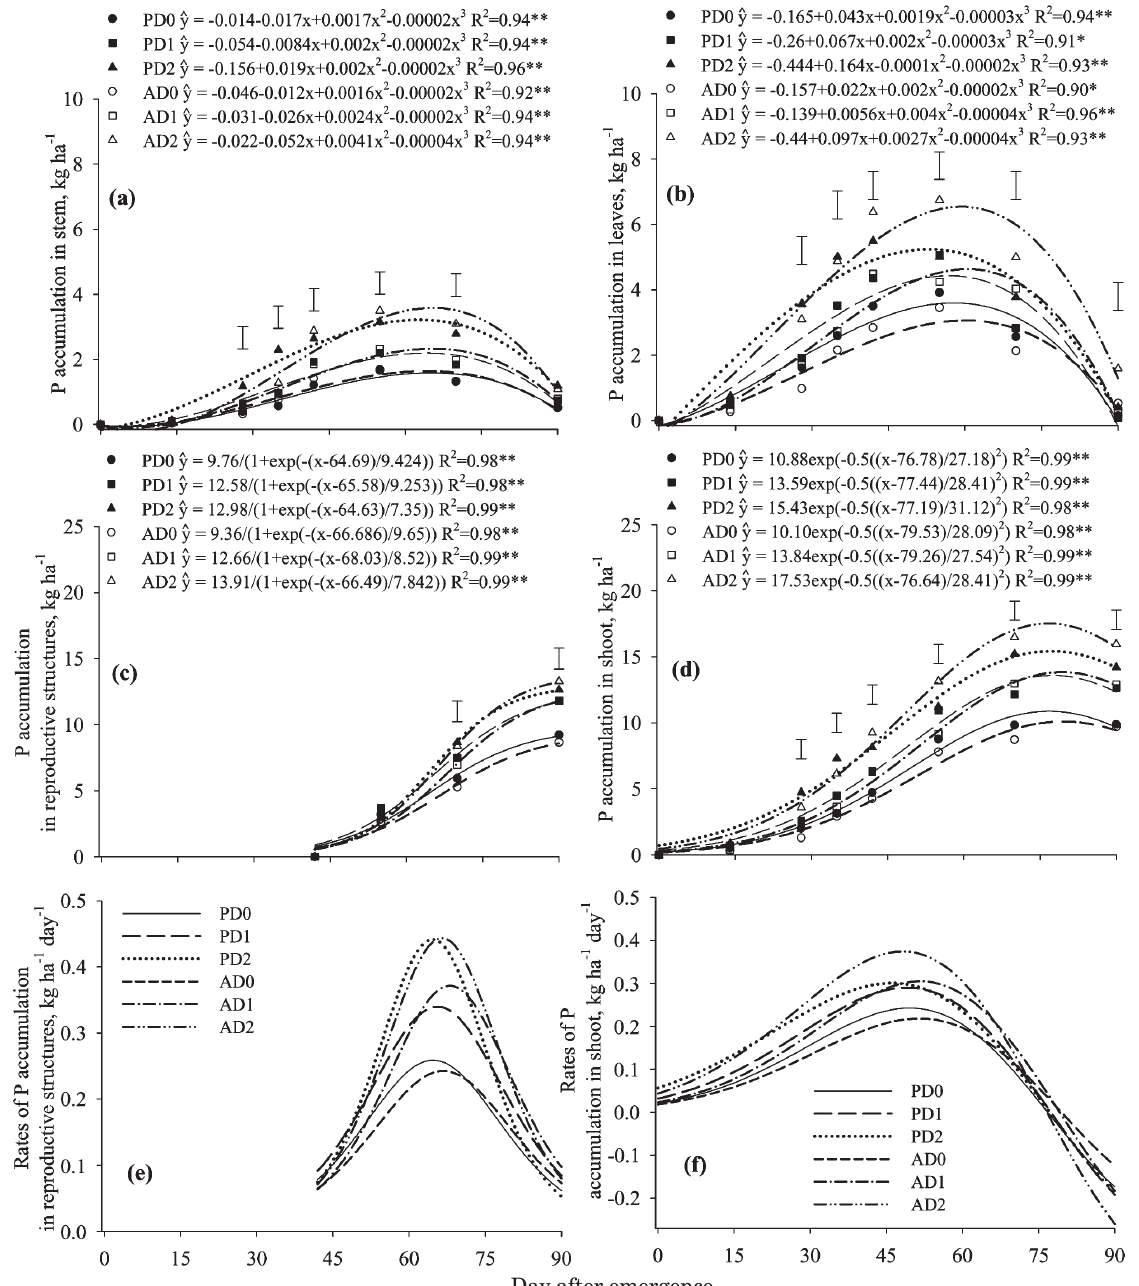
Figure 3. Phosphorus accumulation in stem (a), leaves (b), reproductive structures (c), and shoot (d) and rates of accumulation of P in reproductive structures (e) and shoot (f) of common bean cultivars, under different levels of fertilization. ** and * are: significant at p 0.01 and p 0.05 by the F test. Vertical bars represent the Least Significant Difference (LSD) at p 0.05. PD0 = Pérola without NPK fertilization, PD1 = Pérola with 50 % of recommended NPK fertilization; PD2 = Pérola with 100 % of recommended NPK fertilization; AD0 = IAC Alvorada without NPK fertilization, AD1 = IAC Alvorada with 50 % of recommended NPK fertilization; AD2 = IAC Alvorada with 100 % of recommended NPK